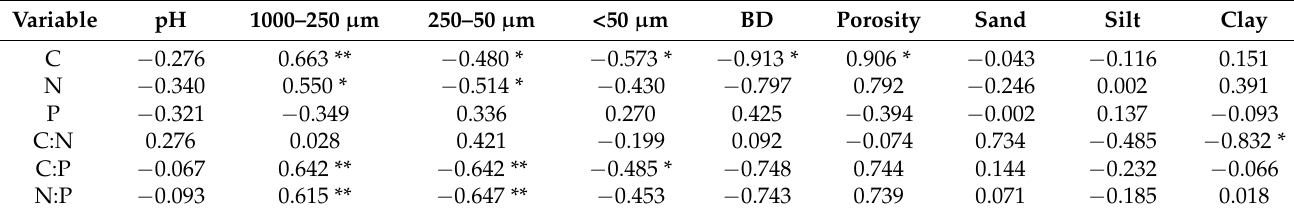
Table 3. Pearson correlation coefficients between selected soil physicochemical properties and C, N, and P concentrations and stoichiometry.